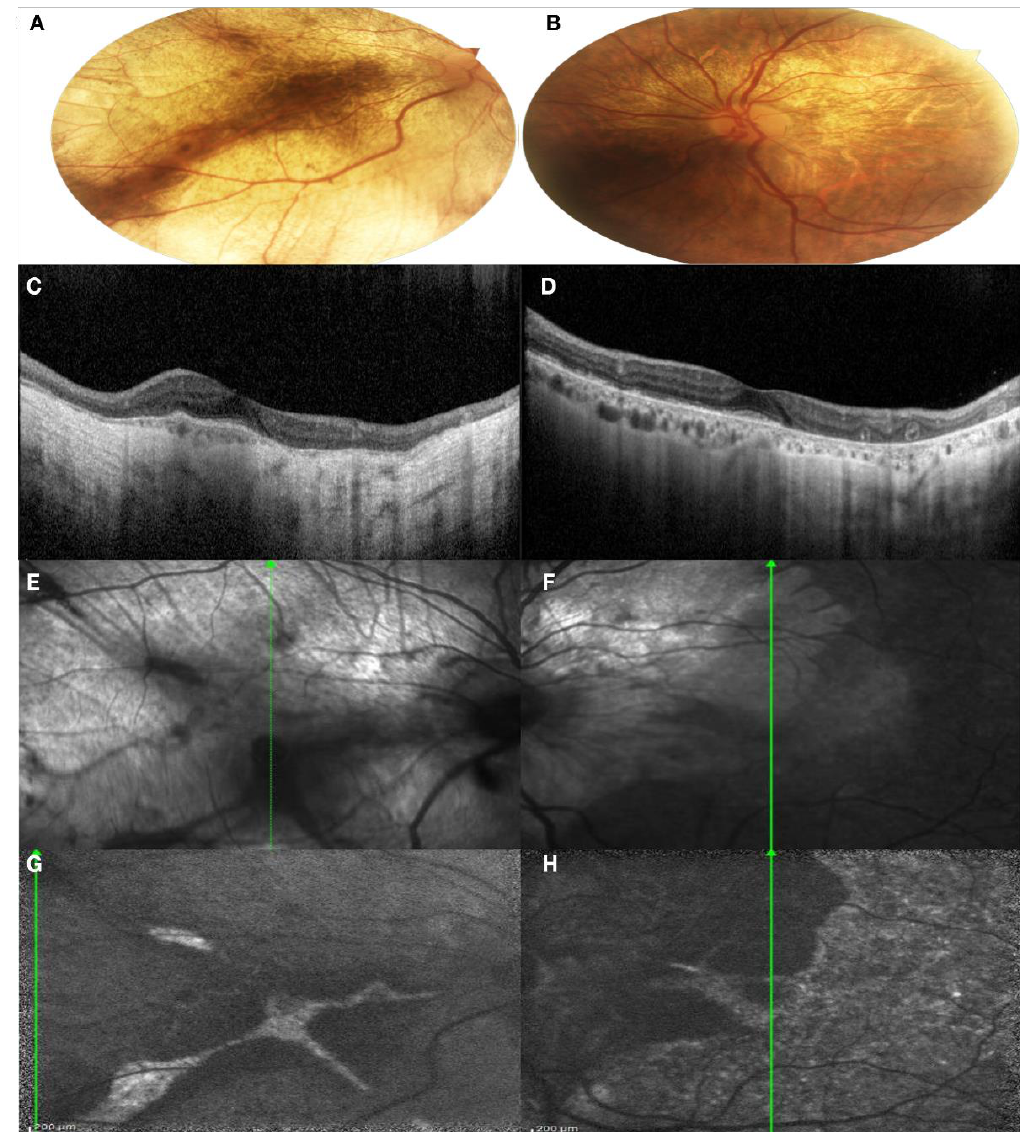
Figure 3. Multimodal imaging of both eyes of Patient I:2. ( A , B ) Color fundus photography of both eyes showed a large bilateral chorioretinal atrophy; ( C , D ) SD-OCT of both eyes showed an extensive chorioretinal atrophy and retinal thinning in the right eye and a residual central island of preserved Ellipsoid Zone (EZ) area in the left eye; ( E , F ) IR images showed areas of residual RPE in the left eye; ( G , H ) FAF showed generalized decreased autofluorescence, with residual areas of autofluorescence in the central macular area in the right eye and also in the temporal macular area in the left eye. ( A , C , E , G ): right eye; ( B , D , F , H ): left eye.